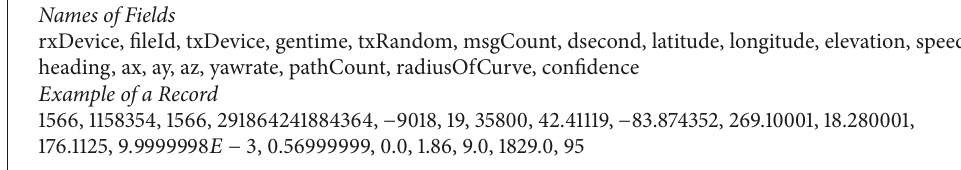
Box 1: Field of names and example of record in the original